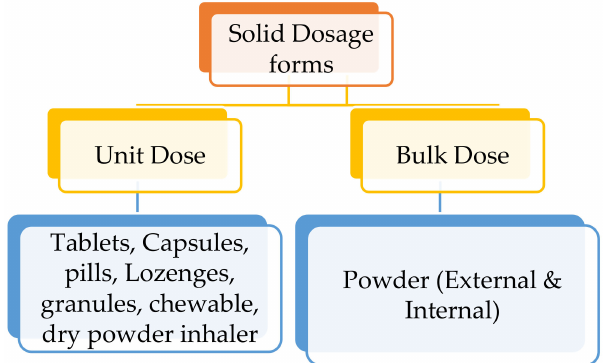
Figure 5. Classification of solid dosage